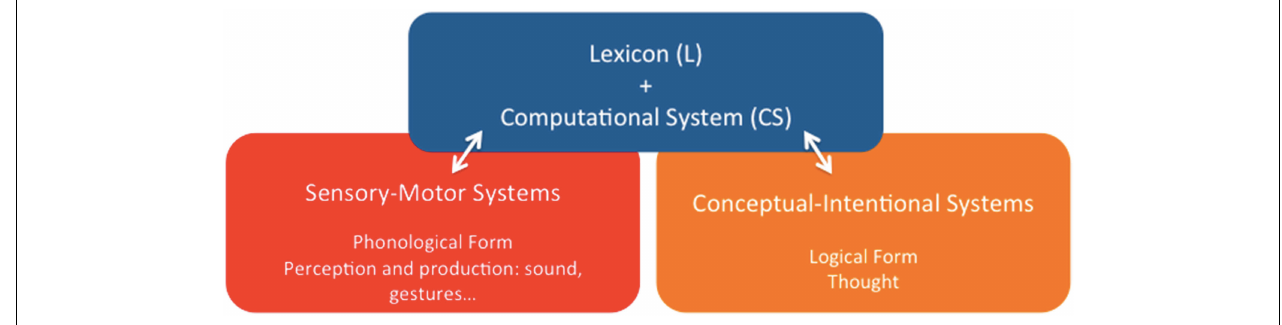
FIGURE 1 | The language phenotype: a minimalist reduction of language to its bare architectural